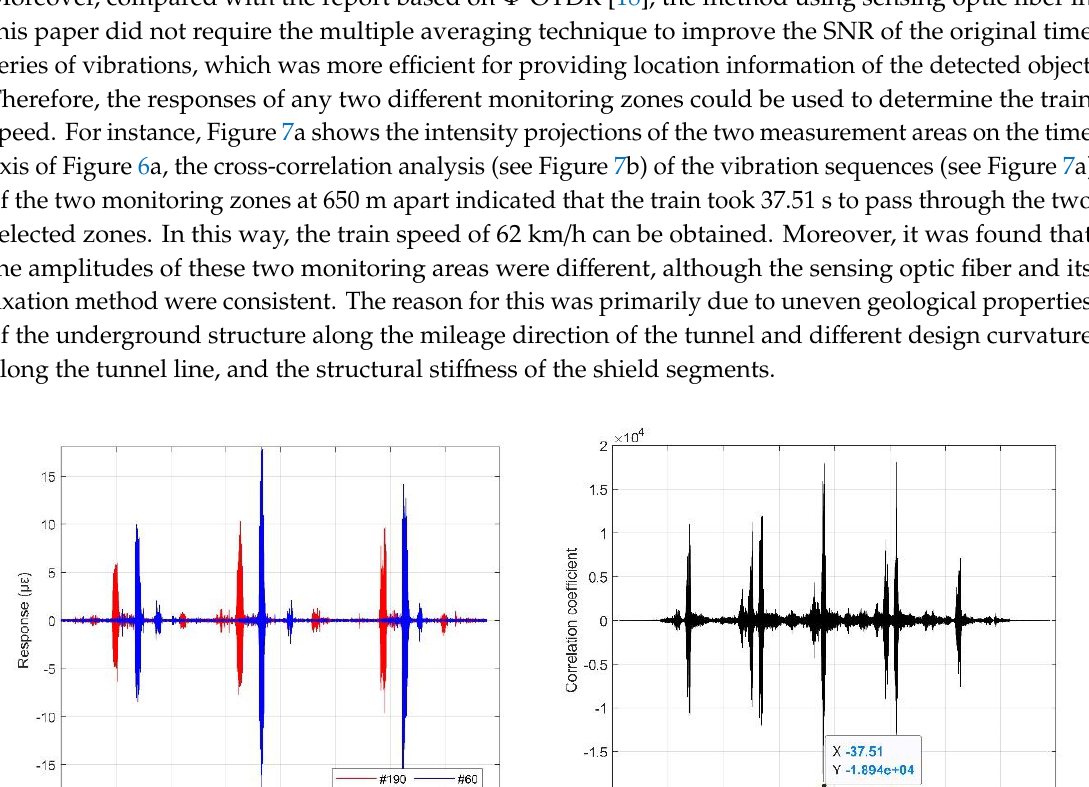
Figure 6. ( a ) Vibration intensity versus space and time under operating train; ( b ) original time series of vibrations of monitoring zone #160.